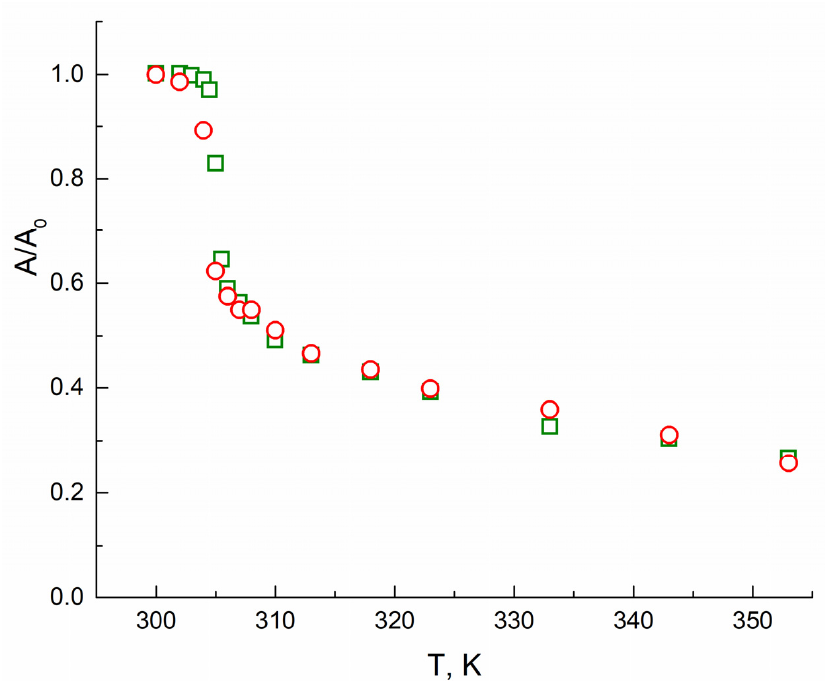
Figure 2. The normalized amplitude of the high-field component of TEMPO EPR signal in PNIPAM solution (green squares correspond to polymer I, red circles correspond to polymer II) vs. tempera- ture.